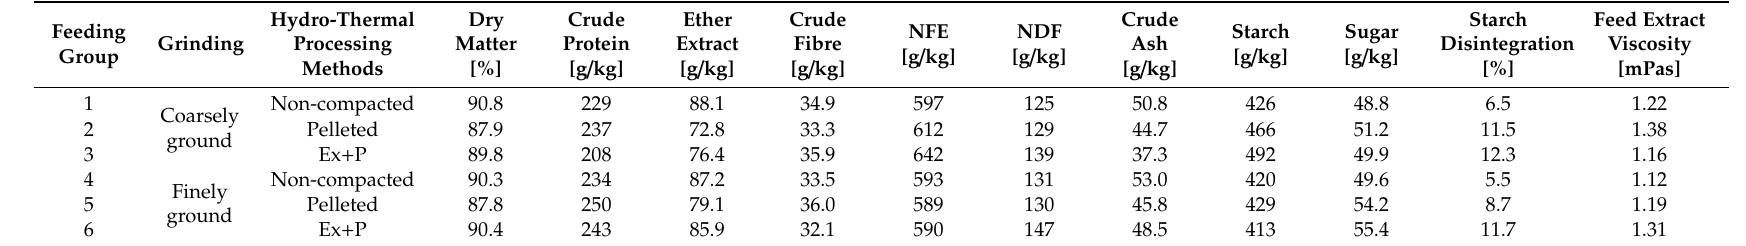
Table 2. Analysed crude nutrients (on dry matter